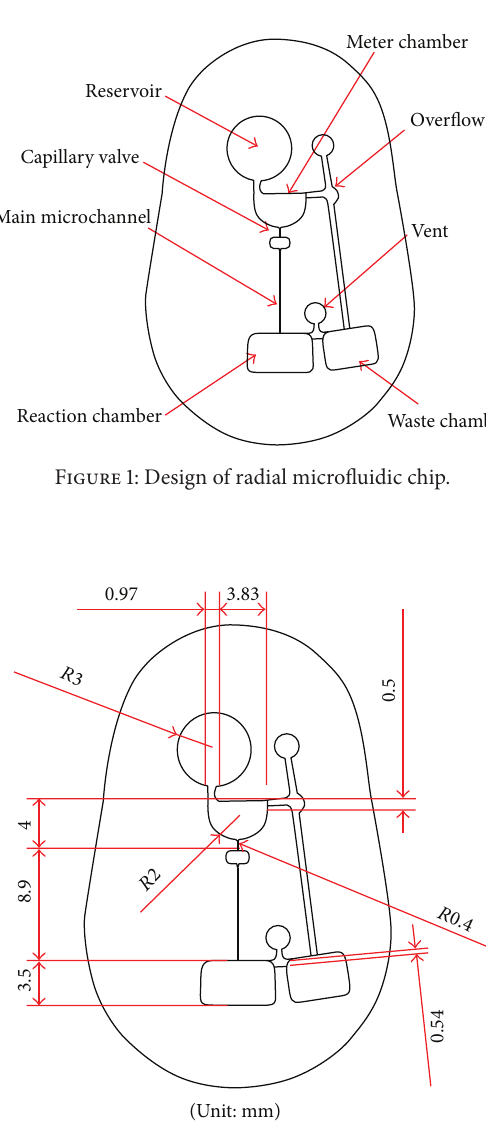
Figure 2: Dimensions of radial microfluidic chip.